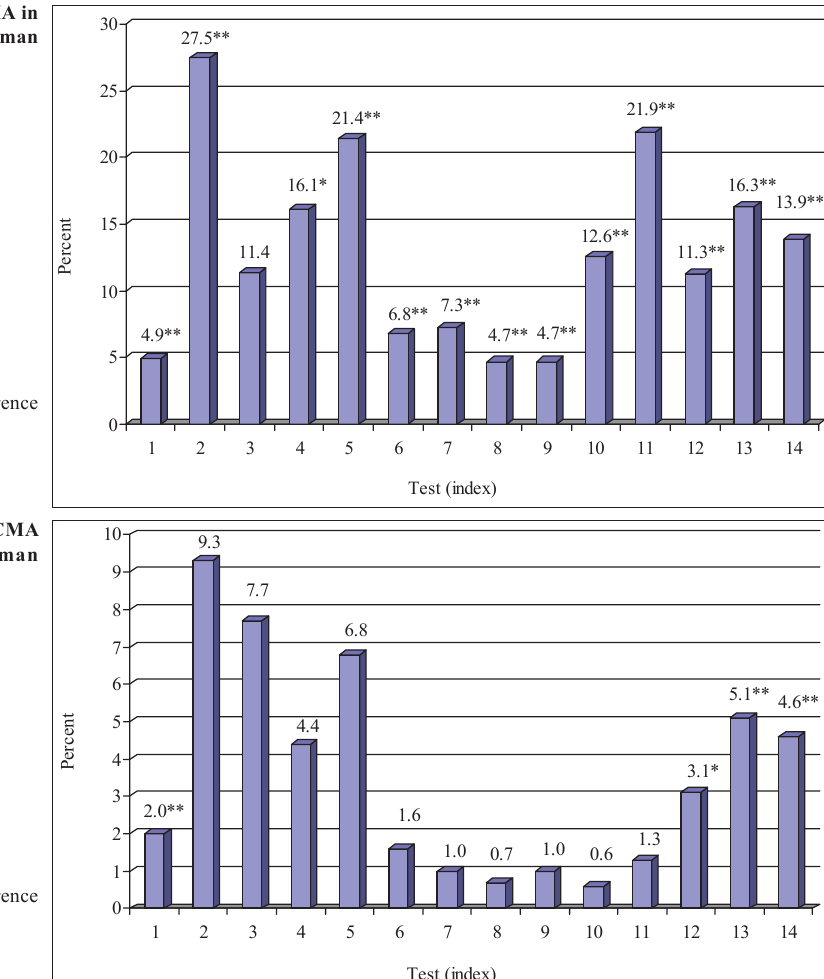
Fig. 2. The increase in the level of CMA in the control group in Greco-Roman wrestlers after the